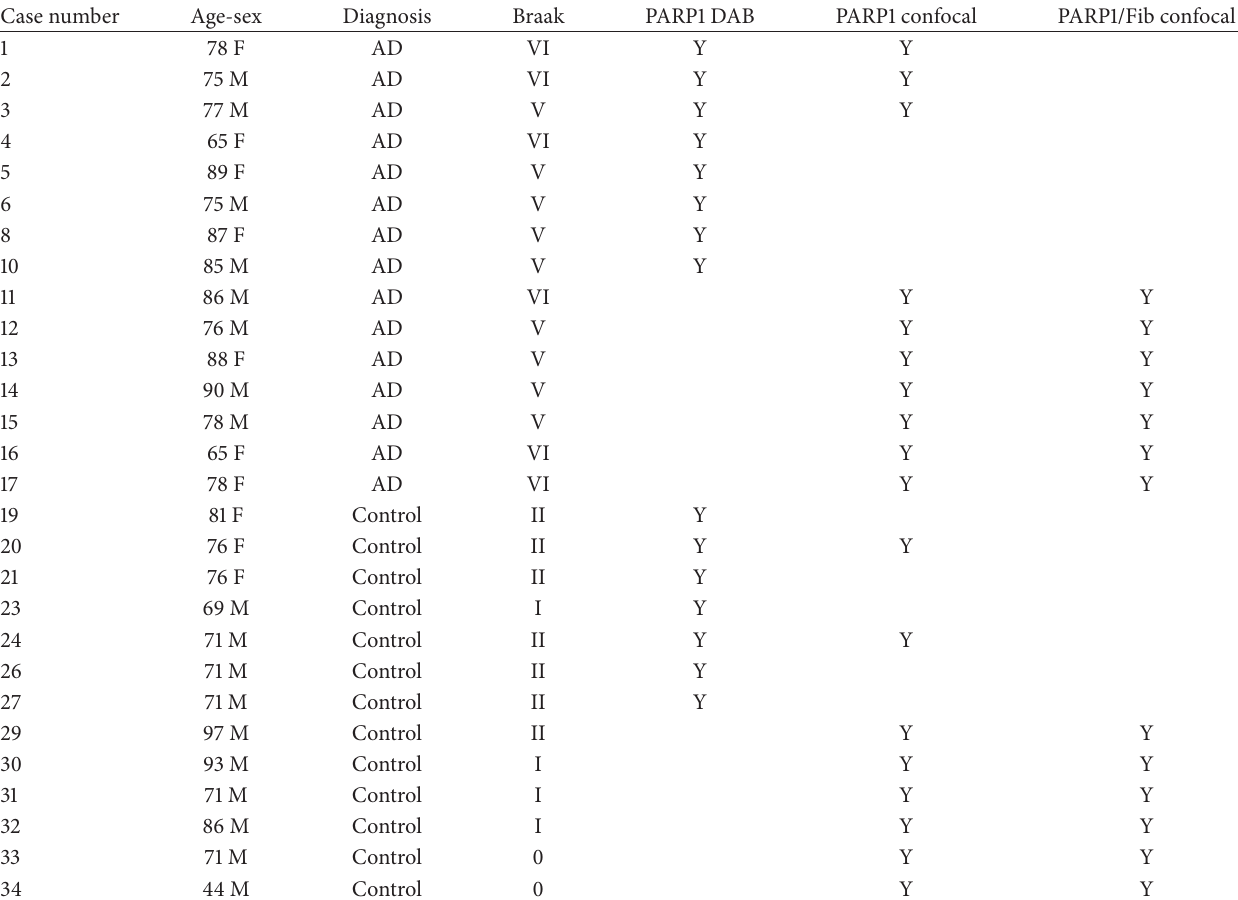
Table 1: Autopsy case